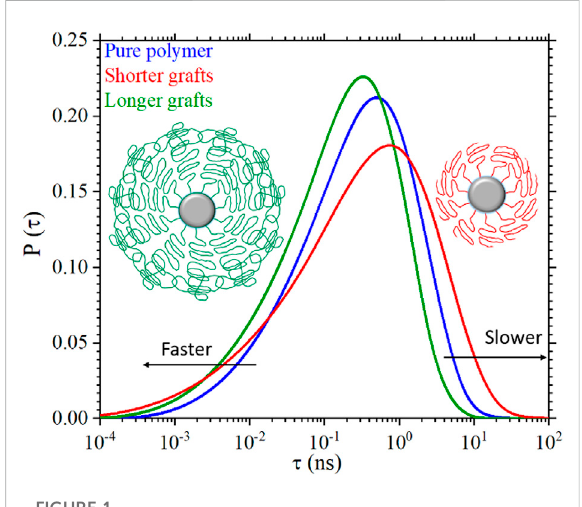
Representative distribution of relaxation times for shorter grafted chains and longer grafted chains as compared to the neat